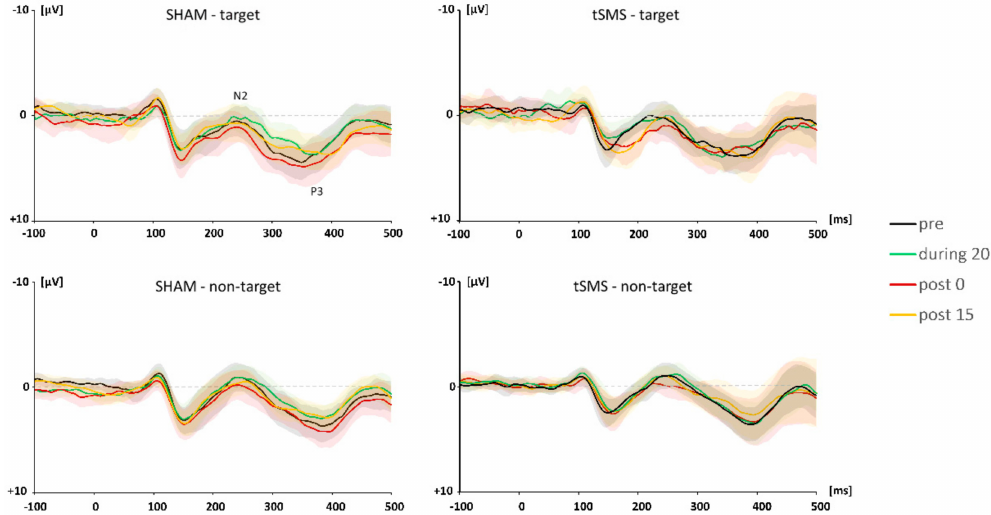
Figure 3. Grand average ERP waveforms for target and non-target trials. The shaded area indicates 95% confidence intervals.